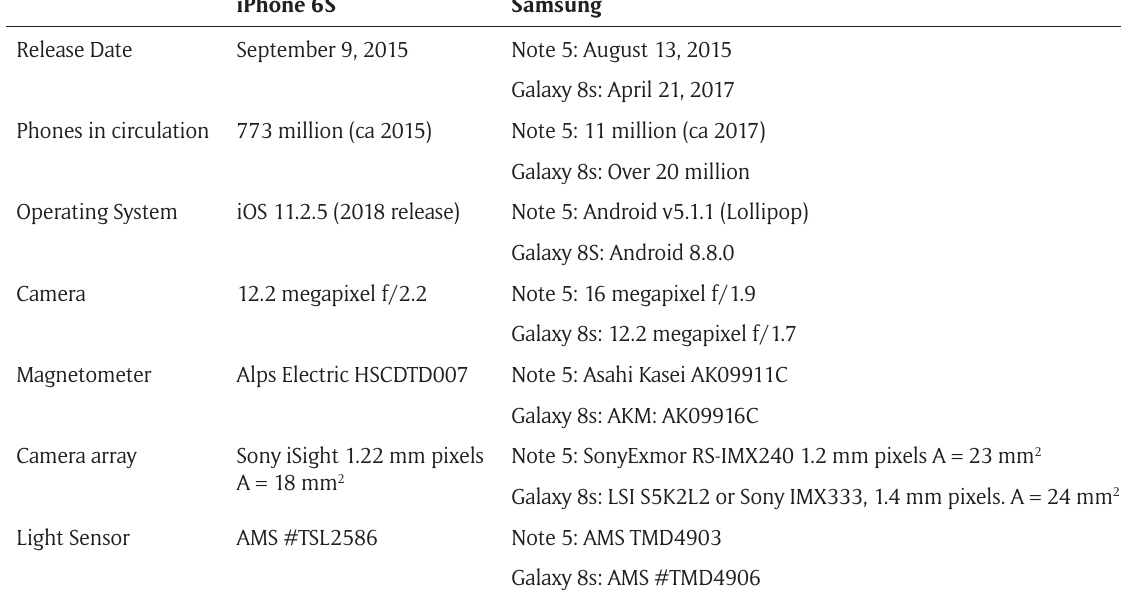
Table 1: Basic details for the iPhone and Samsung smartphone sensor